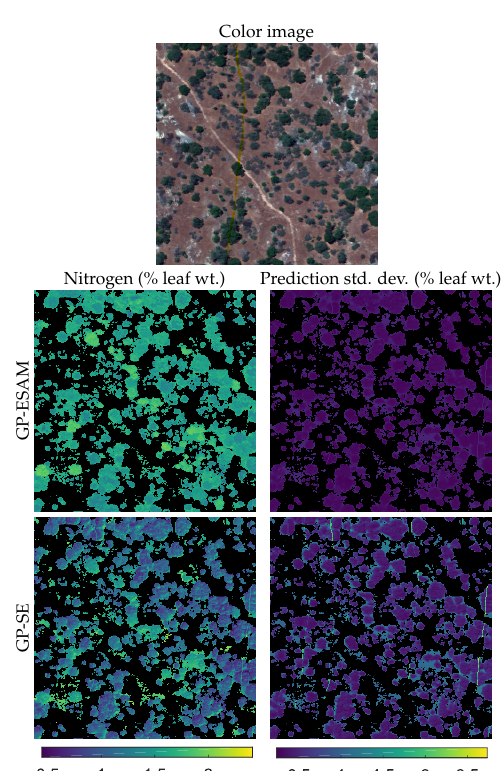
Figure 5. Gaussian processes (GP)-exponential spectral angle mapper (ESAM) and GP-squared exponential (SE) trained on the NEON dataset applied to the test hyperspectral